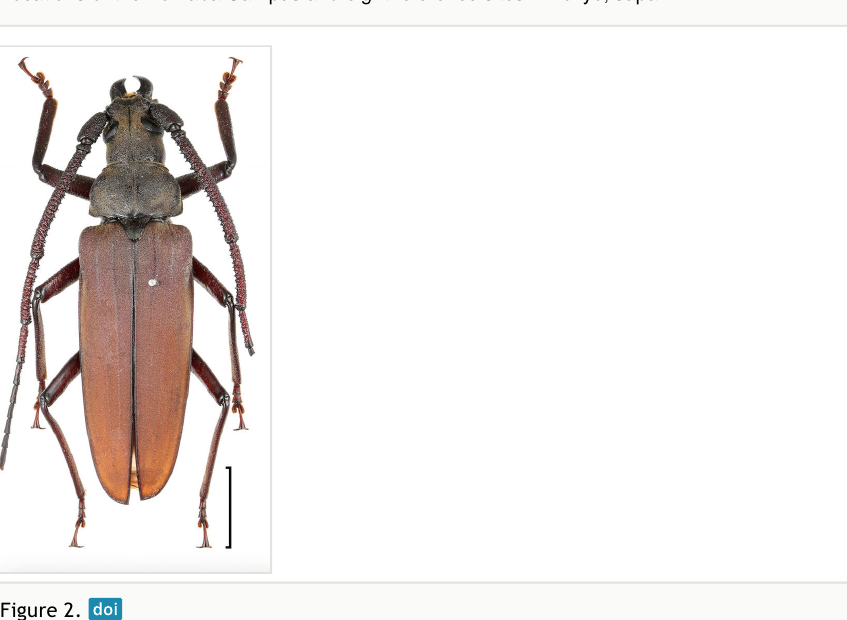
Figure 1. Locations of the Komaba Campus and eight reference sites in Tokyo, Japan.